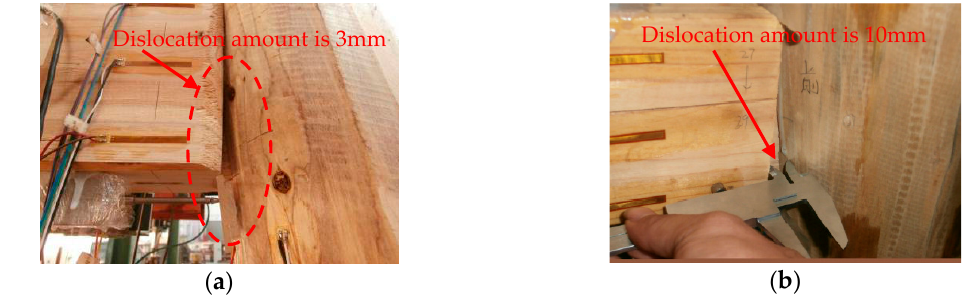
Figure 16. Measured dislocation with a: ( a ) loading amplitude of 80 mm; ( b ) loading amplitude of 160 mm.